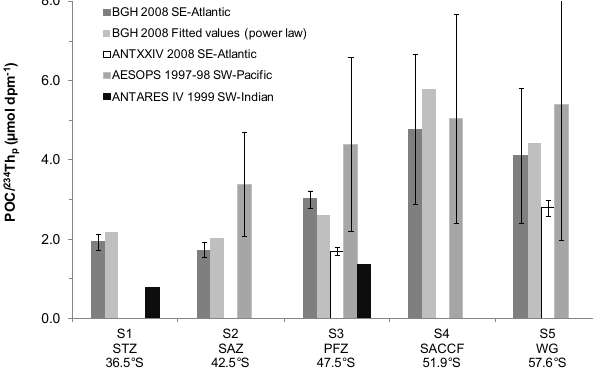
Fig. 6. Comparison of the POC/ 234 Th p ratio (µmoldpm − 1 ) of sink- ing particles ( > 53µm) at the five Super stations (S1 to S5) calcu- lated using (i) average values of POC/ 234 Th p ratios between MLD and 300m depth, and (ii) separate power law fits of the POC and 234 Th p profiles (see text for details). Also shown are POC/ ratios (µmoldpm − 1 ) reported for the ANTXXIV/3 cruise (Rutgers van der Loeff et al., 2011); the AESOPS cruise in the SW Pacific sector (Buesseler et al., 2001) and the ANTARES IV cruise in the Indian sector (Coppola et al.,